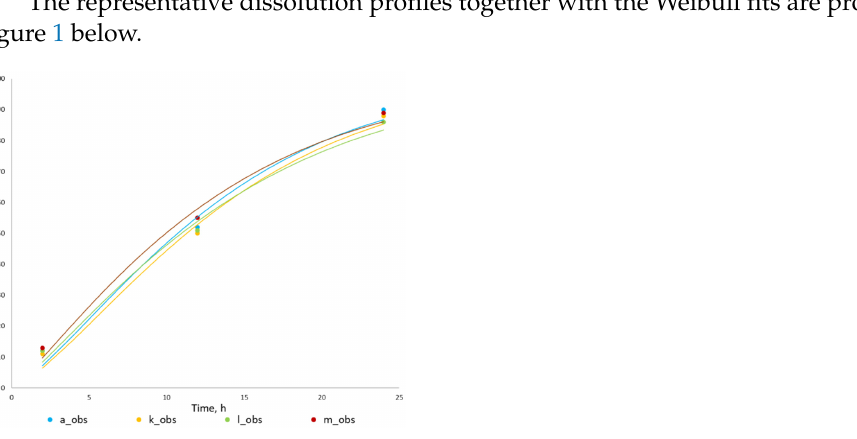
Figure 1. Typical dissolution profiles which were used in the PBPK model. Latin letters (a, k, l, m) indicate simulation ID (please see Table 2), while obs indicates extracted dissolution data and pred —Weibull fit.